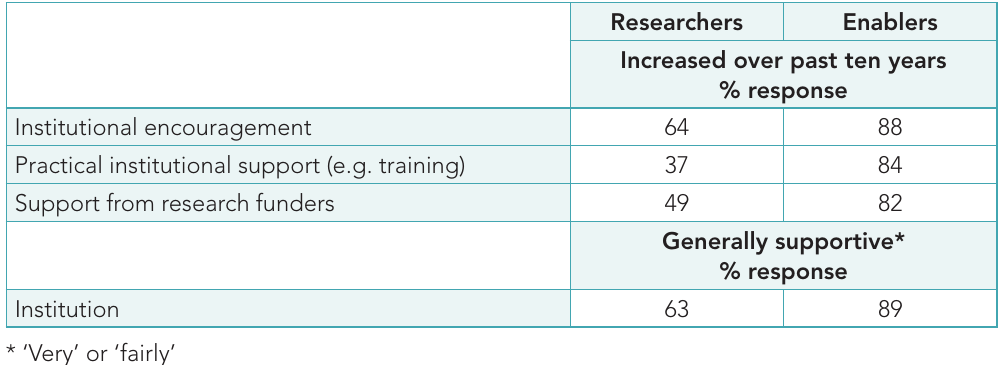
Table 6: Researchers’ and enablers’ views on the institutional